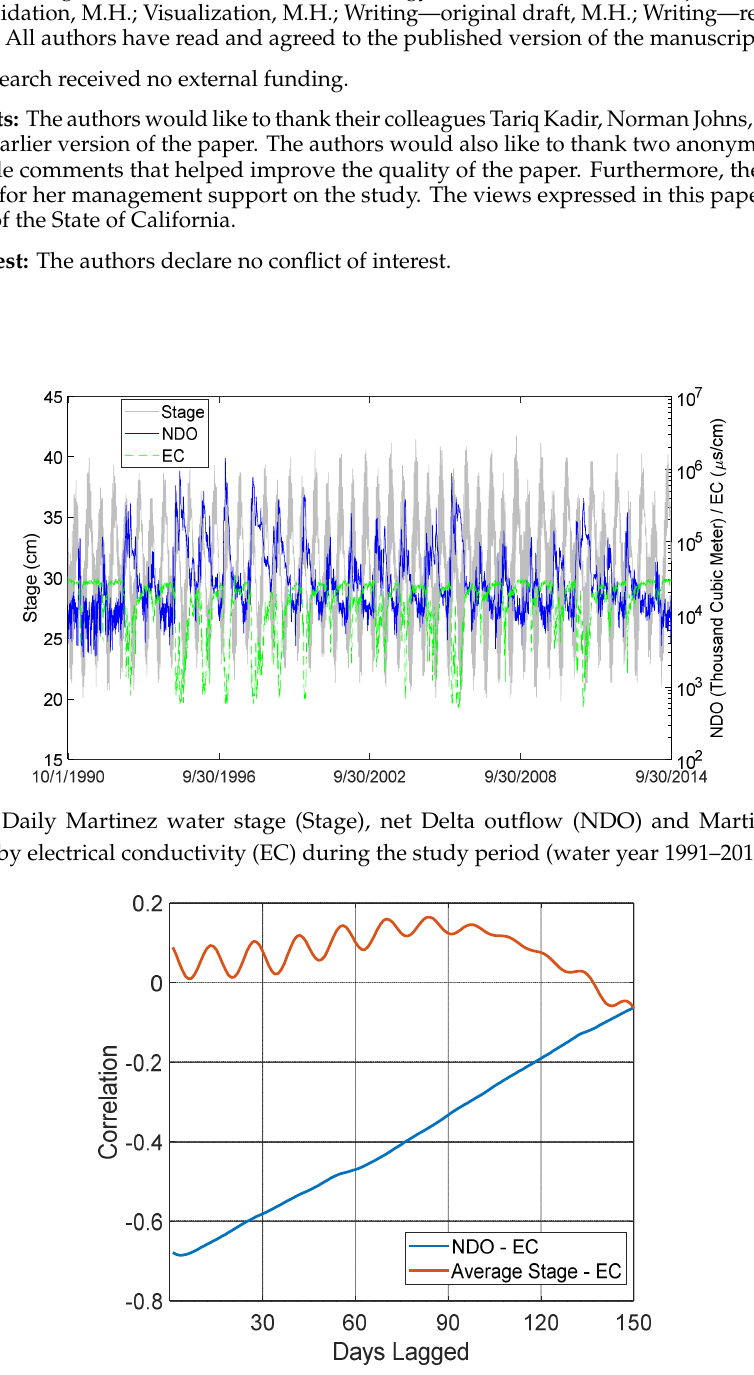
Figure A3. Exceedance probability curves of reference and simulated (via MBSG, MLP4, LSTM4, and the hybrid model) ( a ) salinity and ( b ) high range only salinity during the evaluation period from water year 2003 to 2014. Table A1. The maximum14 day running average of mean daily salinity (EC, µs/cm) at Emmaton and Jersey Point in different types of water year [20]. Water Year Type Emmaton Jersey Point 450 EC from 1 April to Date Shown